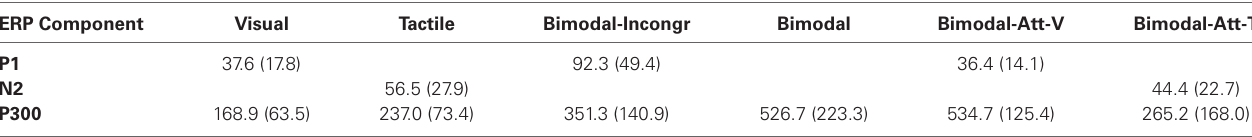
Table 1 | Mean and standard errors averaged over participants of the tAUC-values ( µ V*ms) of all identified ERP components for each condition. ERP